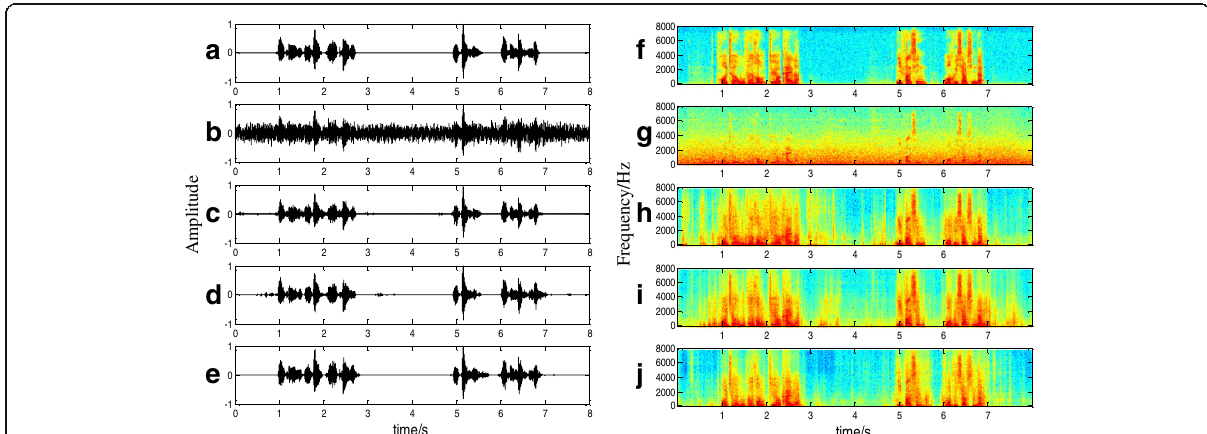
Fig. 7 Speech enhancement effect samples with − 5 dB factory2 noise. a Waveform of clean speech. b Waveform of noisy speech. c Waveform of enhanced speech with the contrast algorithm 1. d Waveform of enhanced speech with the contrast algorithm 2. e Waveform of enhanced speech with the proposed algorithm. f Spectrogram of clean speech. g Spectrogram of noisy speech. h Spectrogram of enhanced speech with the contrast algorithm 1. i Spectrogram of enhanced speech with the contrast algorithm 2. j Spectrogram of enhanced speech with the proposed